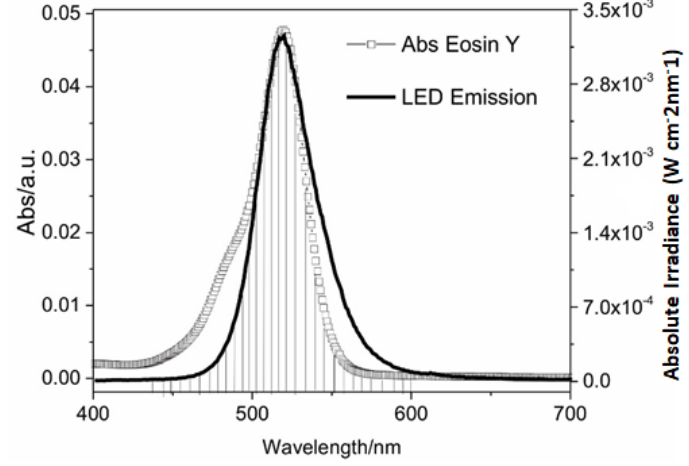
Figure 2. Light-emitting diode emitted potency (P LED Emitted ) and absorbed potency by eosin Y (P Abs ).